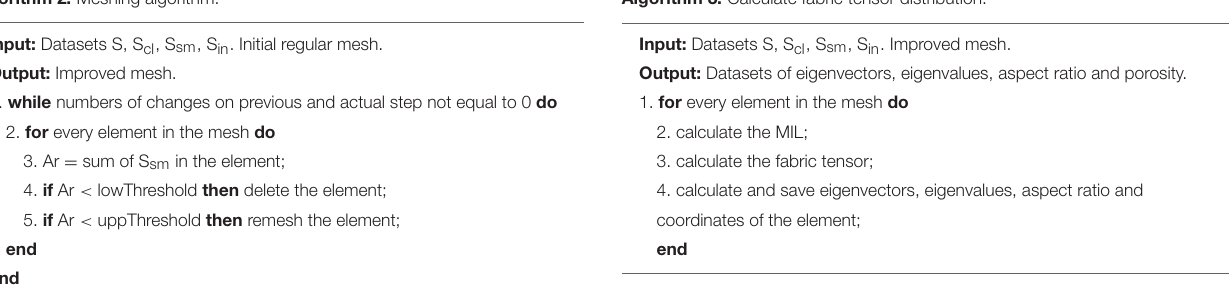
Algorithm 2: Meshing algorithm. Algorithm 3: Calculate fabric tensor